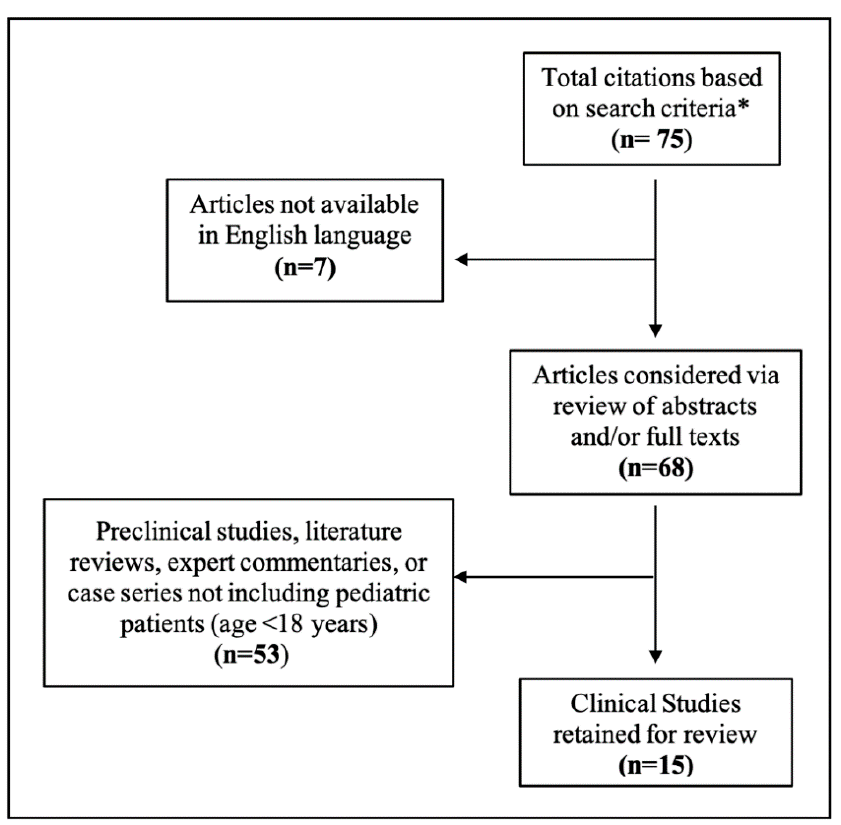
Figure 1. Results of systematic literature review. *Search criteria included ((Pediatric[Title/Ab-